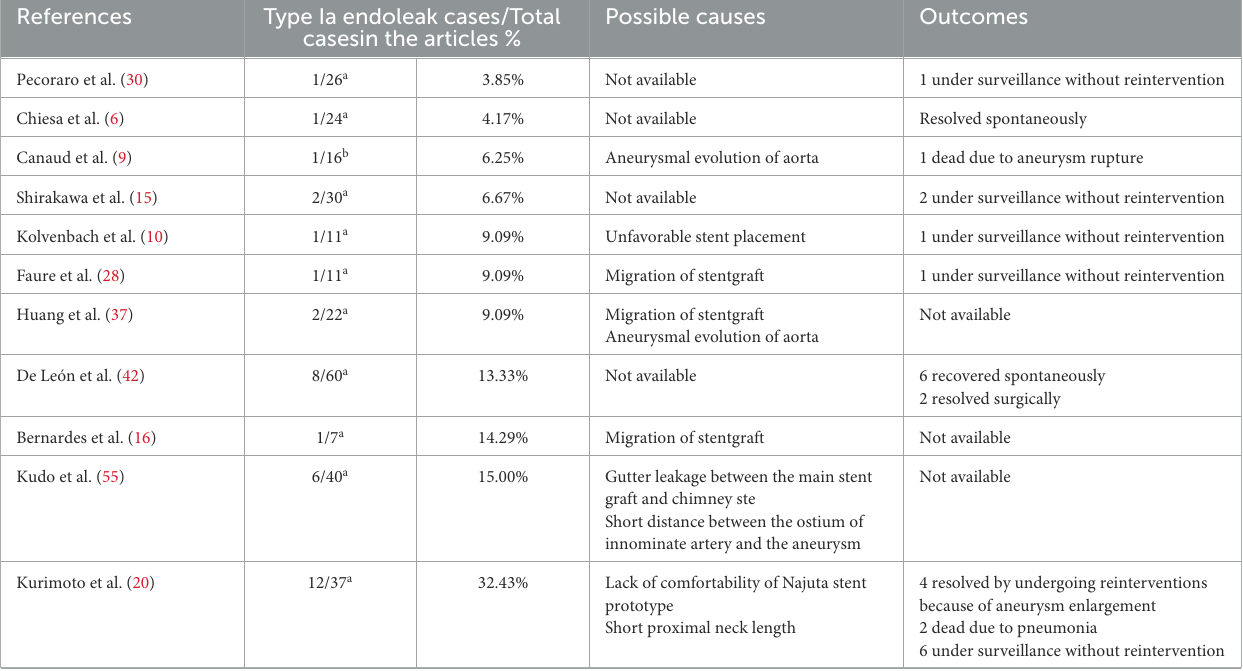
TABLE 7 Possible causes and outcomes of type Ia endoleaks in included studies.